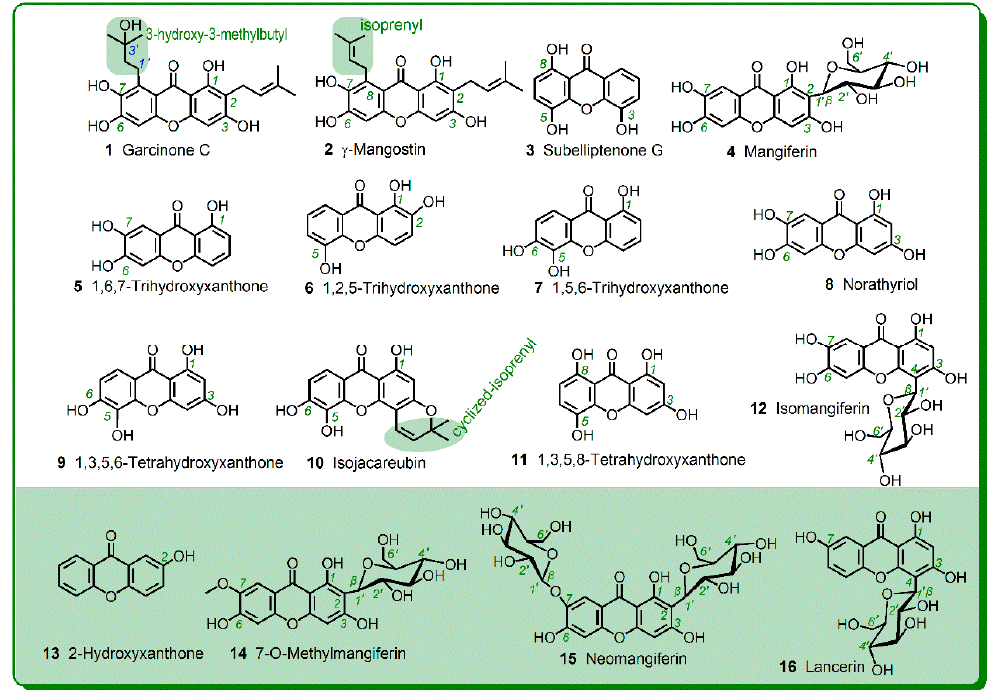
Figure 3. Structures of the 16 selected xanthones.